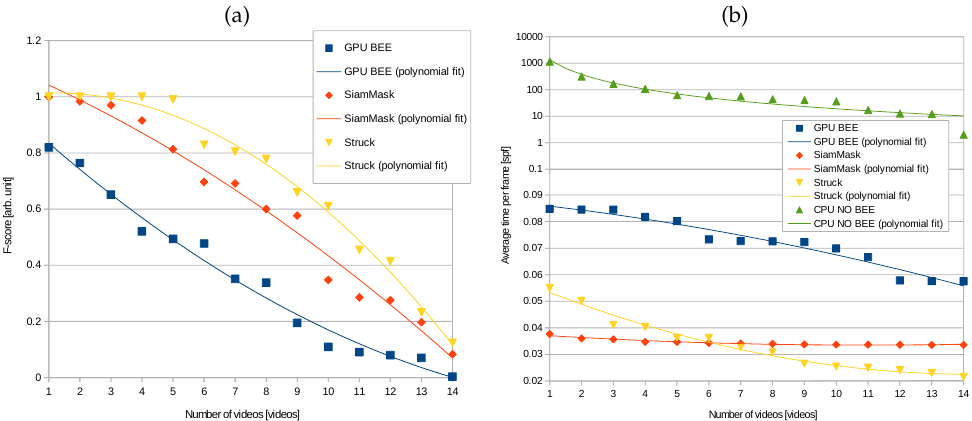
Figure 17. ( a ) Comparison of F-score survival curves between GPU BEE (our best tracker proposal), Struck and SiamMask. ( b ) Comparison of average time per frame survival curves between GPU BEE, CPU NO BEE (conventional NCC), Struck and SiamMask. In the average time per frame axis, the scale from 0.02 to 0.1 is linear but logarithmic above 0.1, in order to contrast substantial difference of average time per frame between CPU NO BEE and the rest of the